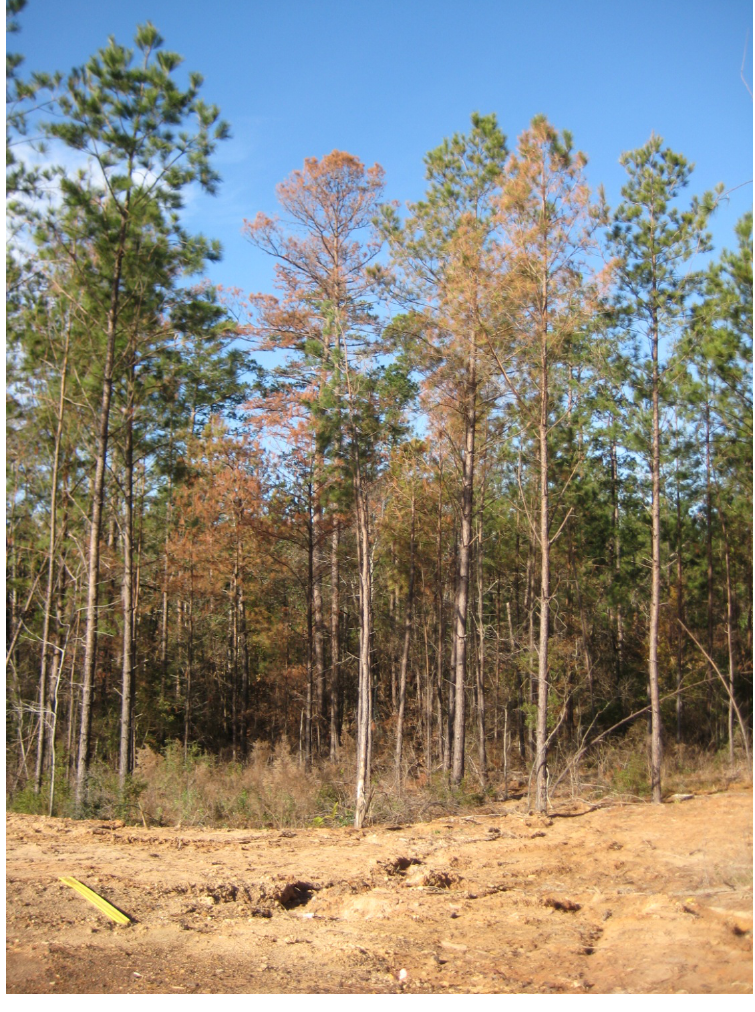
Figure 6. Mortality of loblolly pine overstory trees (red/brown needles) and understory vegetation at F2 at the edge of the streamside buffer strip following an accidental spill in October 2008 of saline water produced during natural gas extraction at the Alto Experimental Watersheds in Texas,